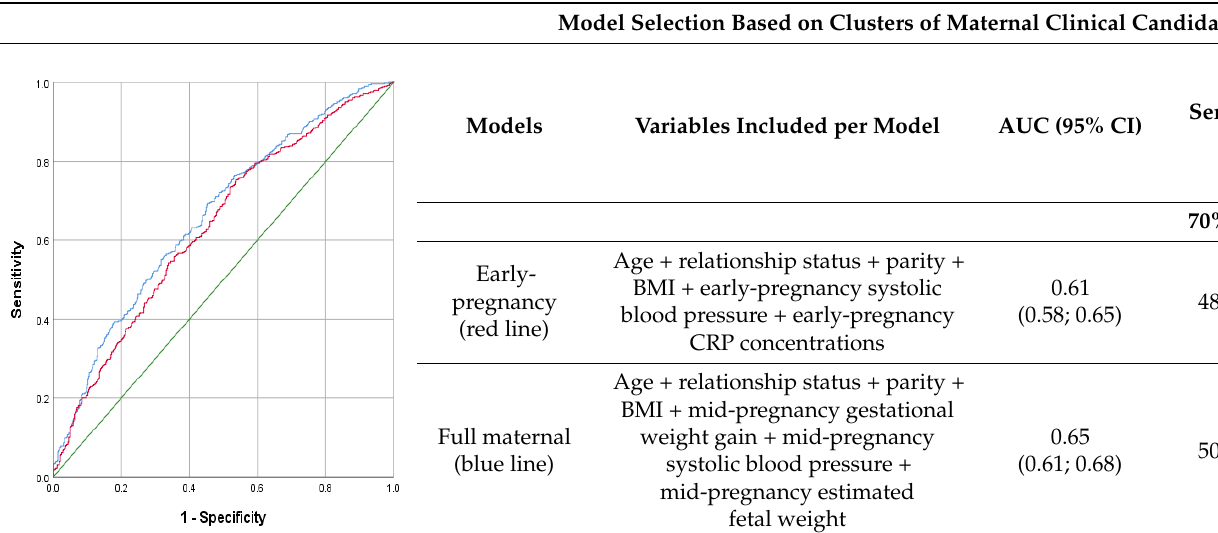
Table 2. Model selection for no adverse outcome of pregnancy.